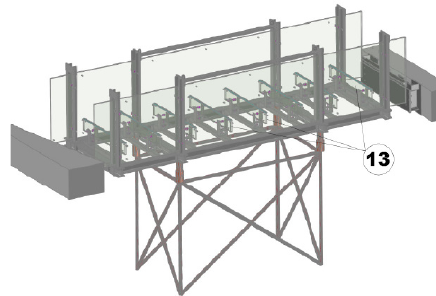
Figure 9: Glass balustrade supported in temporary steel frame.